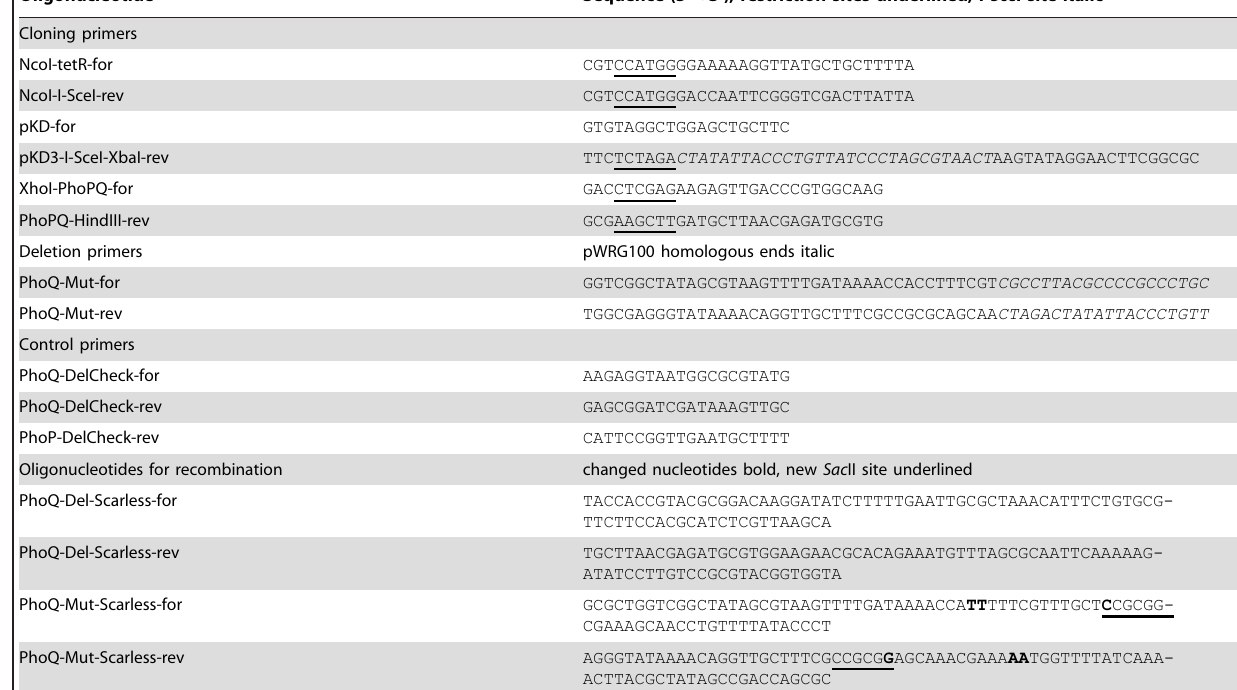
Table 1. Oligonucleotides used in this study.